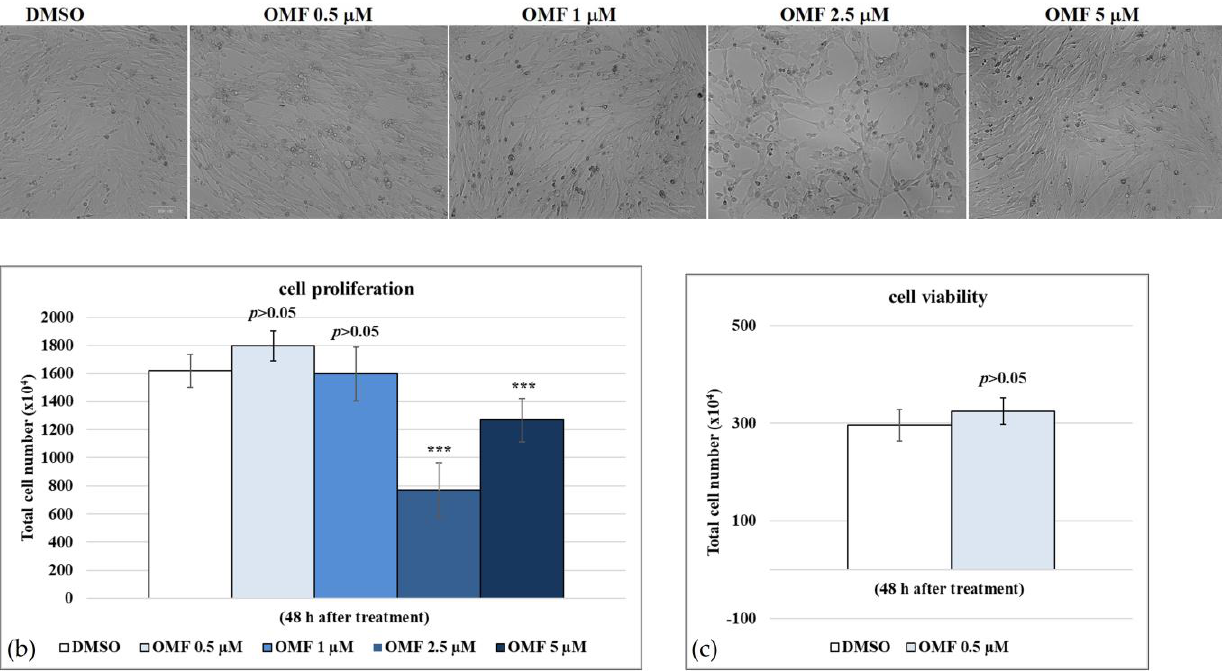
Figure 2. Determination of IC 50 of OMF at various concentrations and development of dose–response curve for A72 cells. ( a ) A72 cells exposed to dimethyl sulfoxide (DMSO) (0.5 µ M) or OMF at various doses (0.5, 1, 2.5, and 5 µ M) at 48 h of treatment. ( b ) Dose–response curve of A72 cells exposed to DMSO (0.5 µ M) or OMF at indicated doses (0.5, 1, 2.5, and 5 µ M). At 48 h after treatment, A72 cells were tested using an MTT assay. ( c ) Cell viability was determined using TB staining and counted using a light microscope. Scale bar 100 µ m. Significant differences between control and OMF-exposed cells were indicated by probability p . *** p < 0.001.